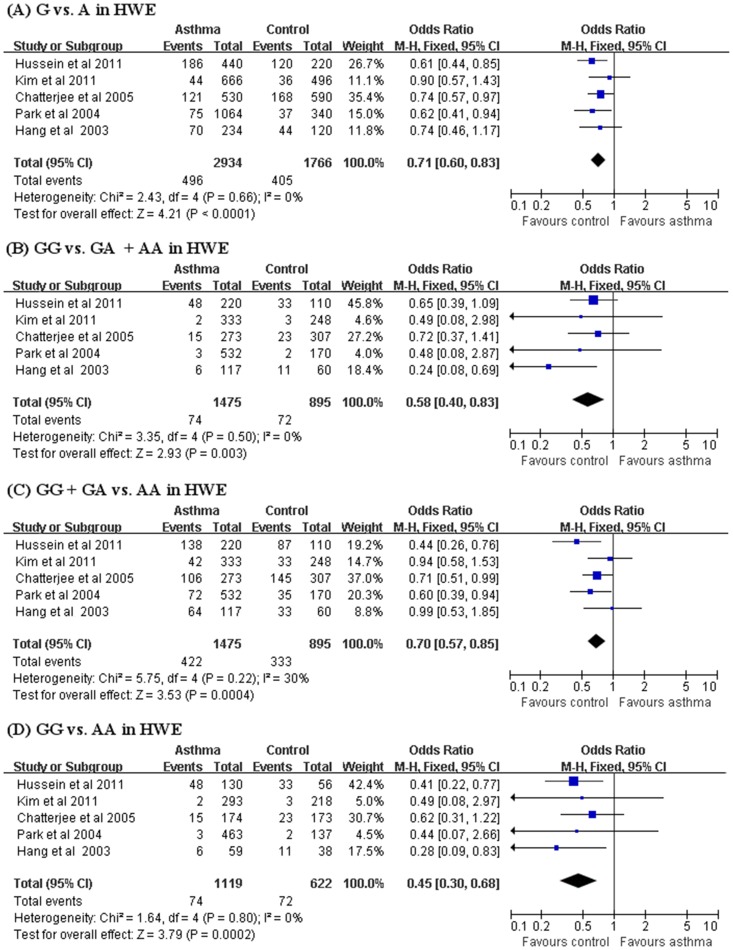
ORs and 95% CIs of individual studies and pooled data for the association between IL-10 -1082 G/A polymorphism and asthma for studies in Hardy-Weinberg equilibrium.(A) G vs. A allele (B) GG vs. GA+AA (recessive) (C) GG+GA vs. AA (dominant model) (D) GG vs. AA (Homozygote contrast).